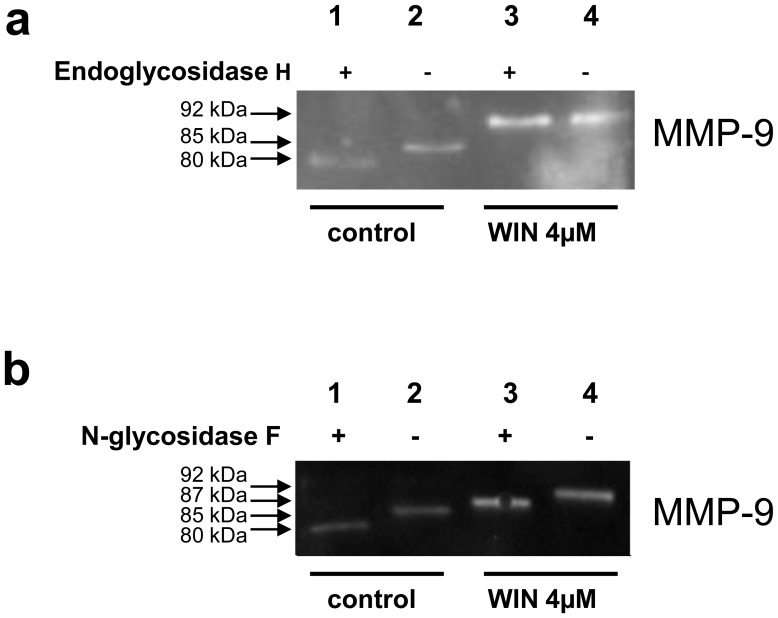
Glycosylation of intracellular 92 kDa-MMP-9 after WIN-treatment was different from the 85 kDa-MMP-9 in untreated U937-macrophages.The pictures show one representative analysis out of three. (a) Western blot analysis using anti-MMP-9 antibody of endoglycosidase H-digested cell lysates treated with or without WIN. The WIN-induced 92 kDa-MMP-9 was resistant to digestion, whereas the 85 kDa-MMP-9 from control cells loses 5 kDa upon digestion. (b) Digestion with N-glycosidase F resulted in a loss of 5 kDa in both MMP-9 forms.